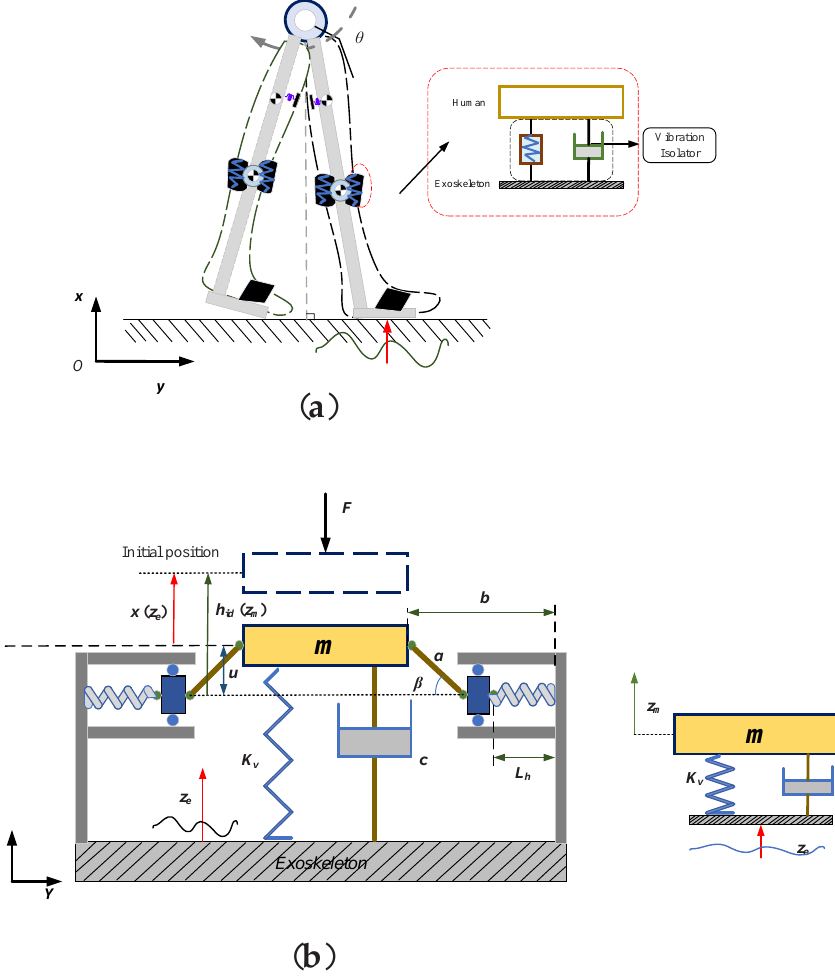
Figure 3. Overview of the model structure schematics: ( a ) Diagram of vibration isolation structure with negative stiffness. ( b ) Schematic diagram of HRI with vibration-isolation